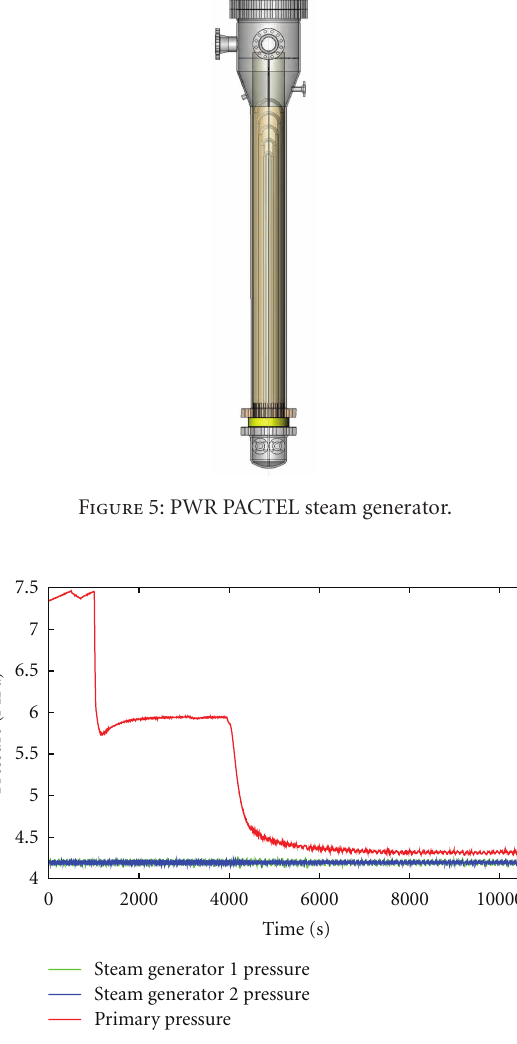
Figure 6: Primary- and secondary-side pressures in PWR PACTEL benchmark